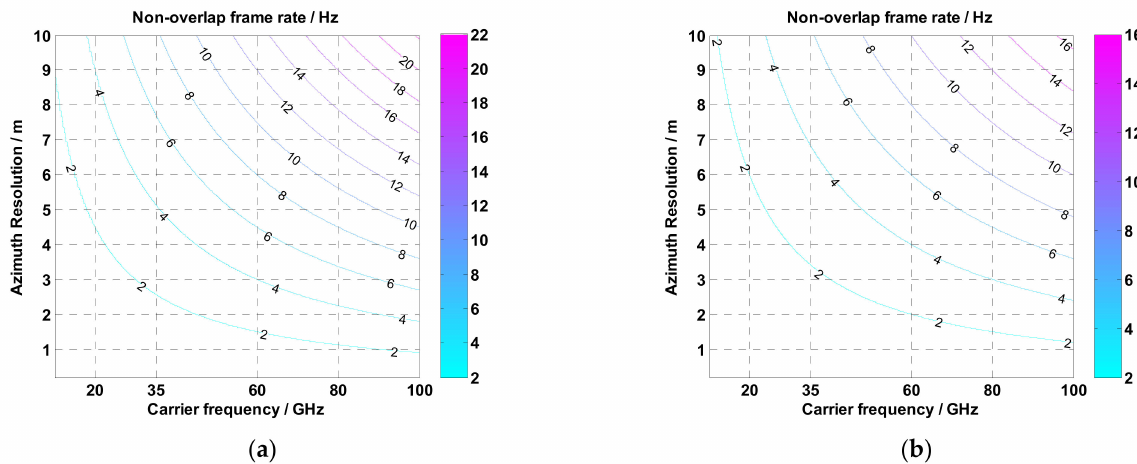
Figure 2. Non-overlap frame rate results of typical airborne ViSAR system with velocity of 100 m/s and scene center slant range of 30 km. ( a ) squint angle equals to 0 degree. ( b ) squint angle equals to 30 degrees. The unit of the color bar is